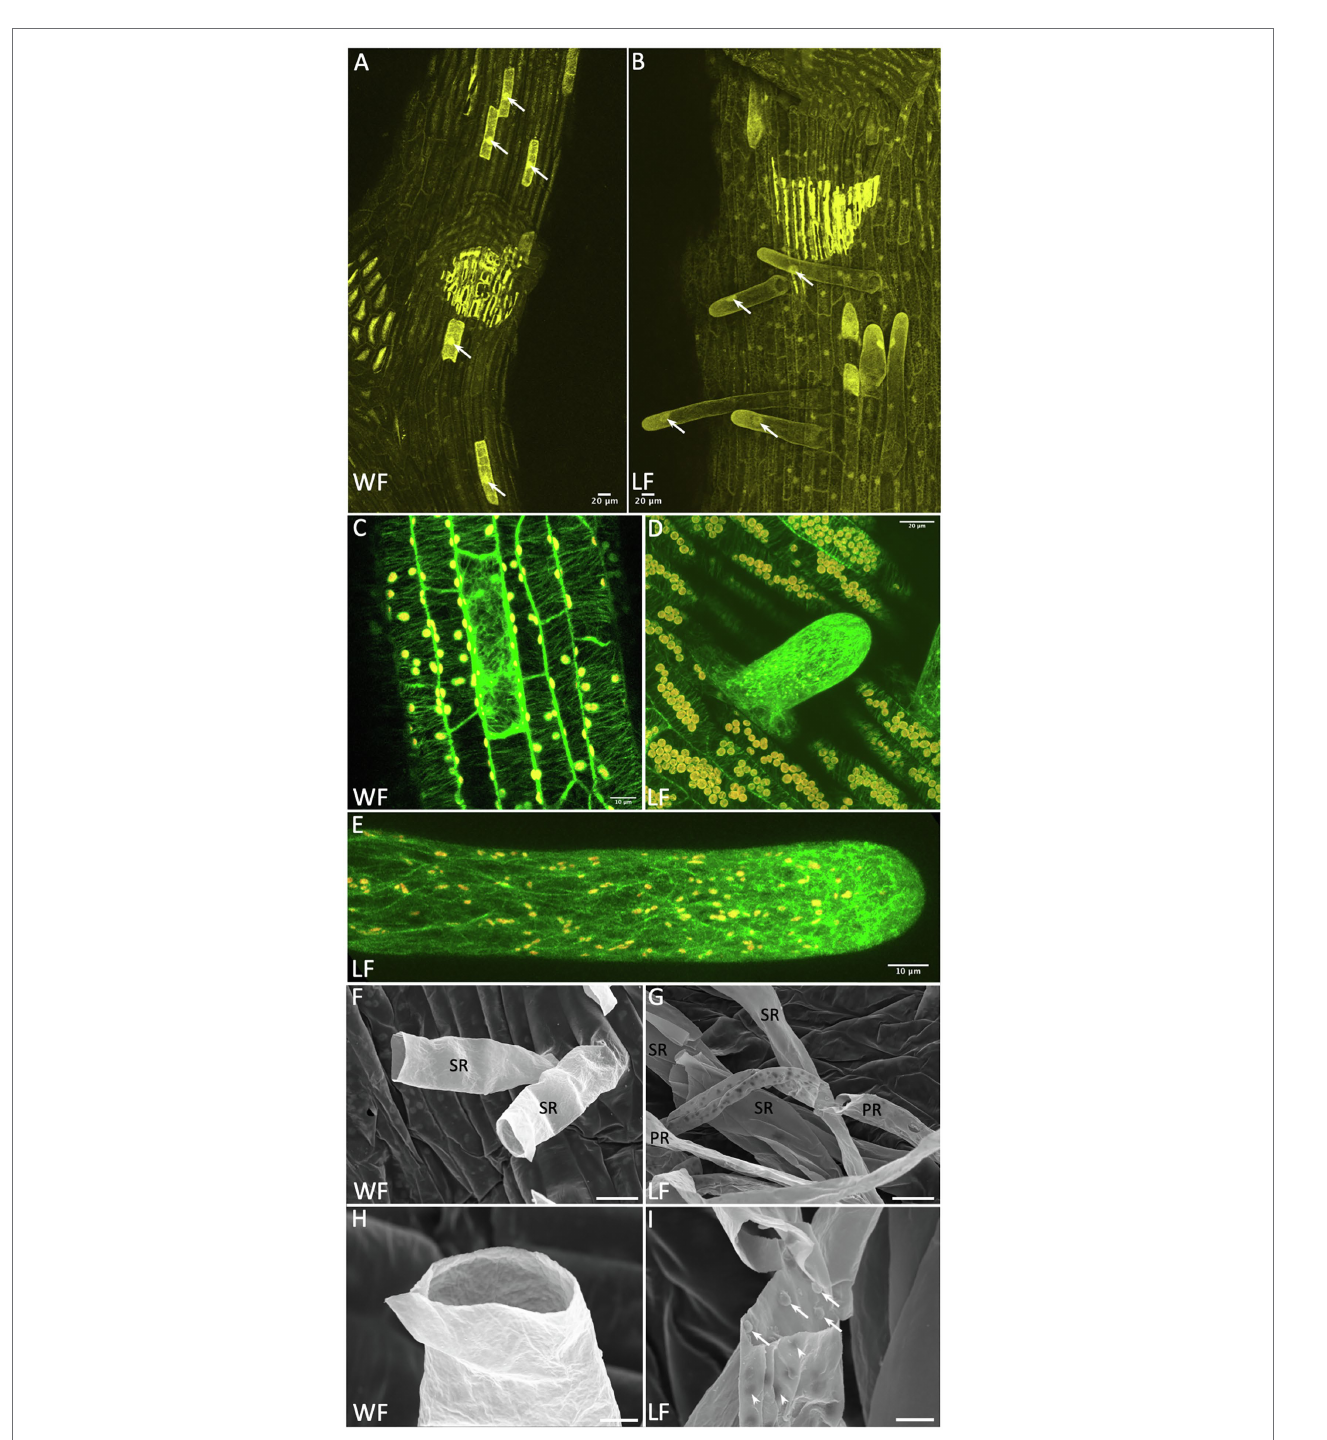
FIGURE 4 | Rhizoid development in the Riccia fluitans WF and LF. (A) pro Mp EF1 α : mCherry expression in the ventral WF thallus. Nuclei (arrows) of hypothesized rhizoid initials appear larger than those in surrounding epidermal cells. (B) LF mCherry expression, rhizoids with enlarged nuclei are growing out (arrows). (C) pro Mp EF1 α : GFP- Mp TUB1 expression in ventral WF thallus reveals in some epidermis cells, in contrast to neighboring cells with a parallel, a transversely oriented microtubule array. In outgrowing young (D) and older smooth (E) LF rhizoids, microtubule density increases heavily toward the tip. (F–I) Scanning electron microscopy (SEM) analyses of rhizoids. (F) Sections through WF rhizoids reveal only smooth rhizoid (SR) formation. (G) Sections through LF rhizoids showed mostly SR and occasionally pegged rhizoid (PR) formation, with variable peg density recognizable from the outside as dark dots. (H) Detail of a WF SR with smooth inner and outer surface. (I) Detail of a LF PR revealing invaginations on the outer surface (arrowheads) derived from pegs formed as extensions from the inner cell wall, protruding into the rhizoid (arrows). Scale bars: 20 μ m, except (C,E) 10 μ m; (H,I) 5 μ